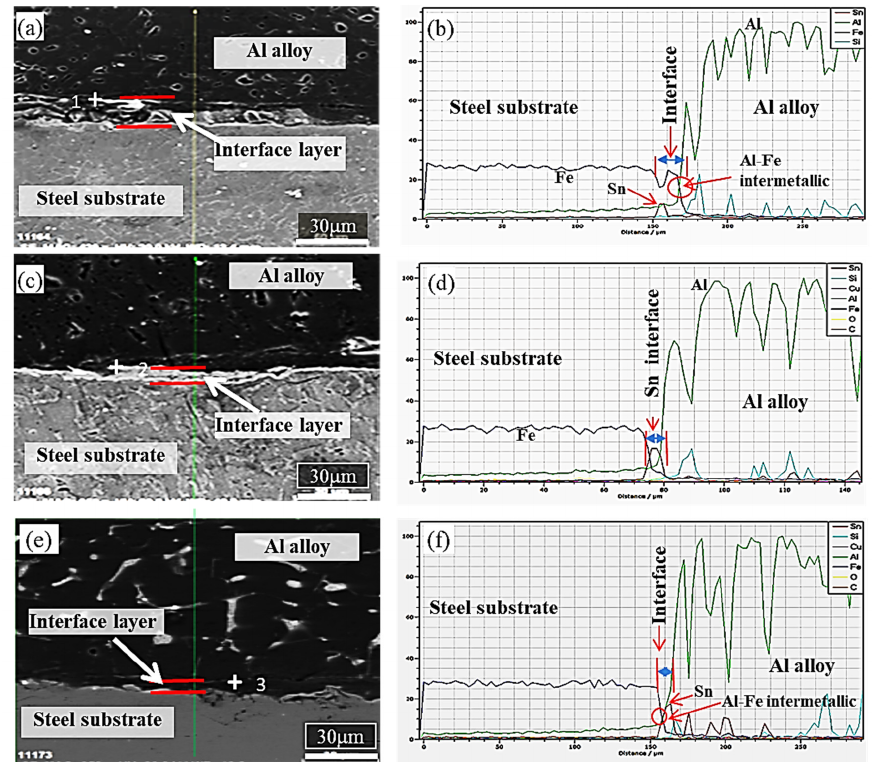
Figure 5. SEM ( a , c , e ) and EDS ( b , d , f ) analysis and line scan results across the interface of bimetallic materials using the tin:flux ratios of percentage of 1:5, 1:10 and 1:15.